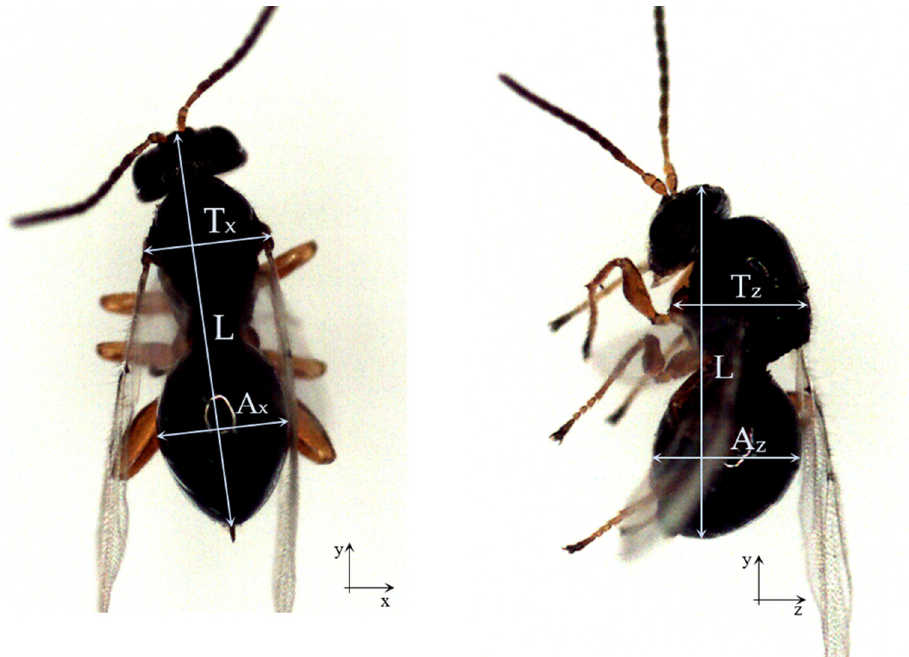
Figure 2. Individual of D. kuriphilus (dorsal view ( left ), lateral view ( right